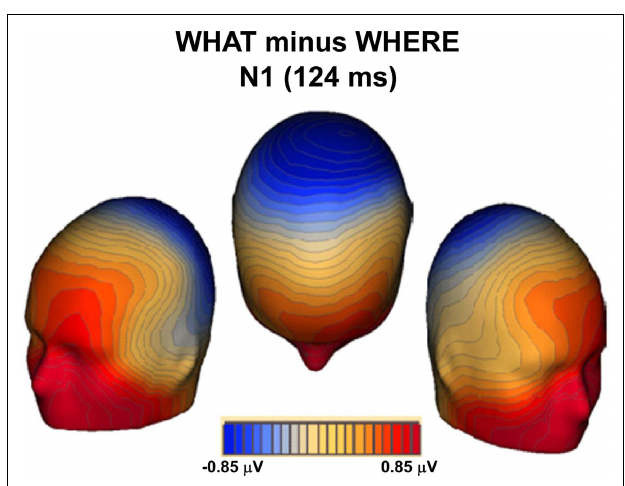
FIGURE 9 |Topographic map of the differences between conditions ( WHAT minus WHERE ) during the N1 timeframe.